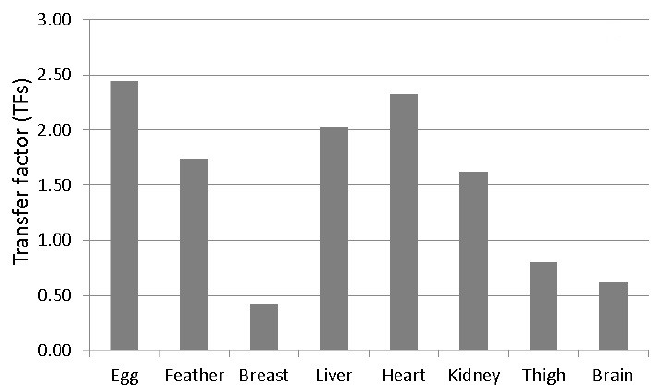
Figure 1. Fipronil and fipronil sulfone transfer factors (TFs) in different hen districts. Fipronil and fipronil sulfone are lipophilic molecules (octanol/water partition coefficient = 4), and the yolk is a matrix with a high lipid content; thus, the two a.i.s easily migrate from feed to yolk. In addition, the datasheet of some pet formulations reported fipronil accumulation in fat and sebaceous glands, followed by a slow and sustained release of the pesticide for 30 days